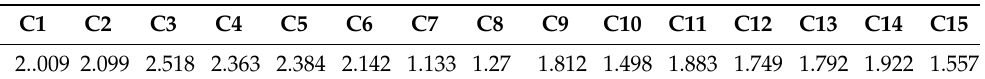
Table 5. The sum of columns.